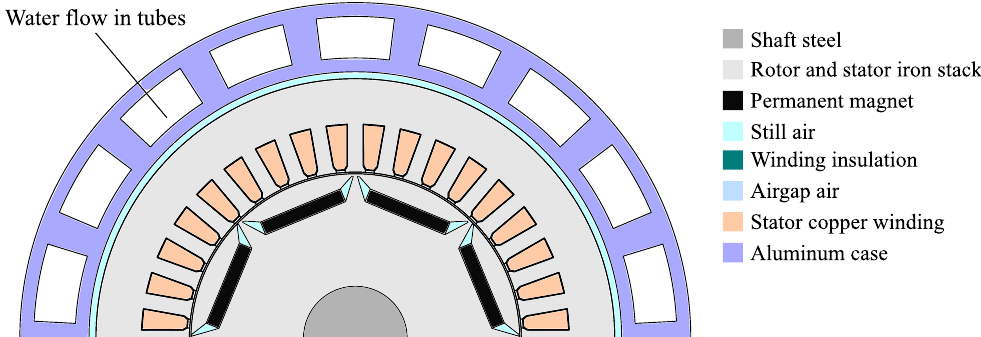
Figure 34. Motor model for the thermal finite element simulation of the IPM motor with a water cooling system.